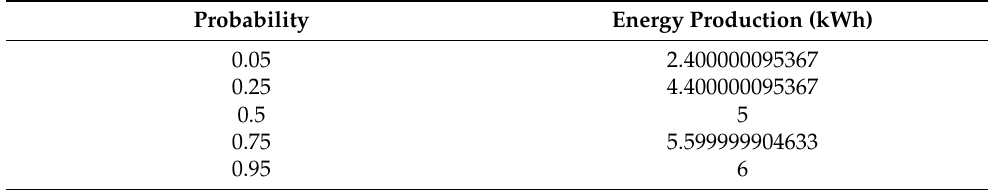
Table 1. Quantile